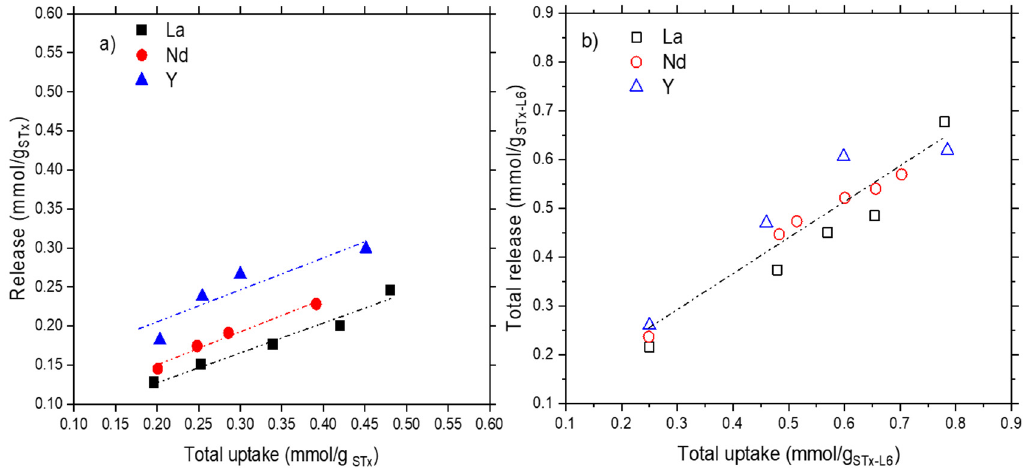
Figure 6. Release as a function of the total uptake in ( a ) pristine STx and ( b ) modified STx-L6.